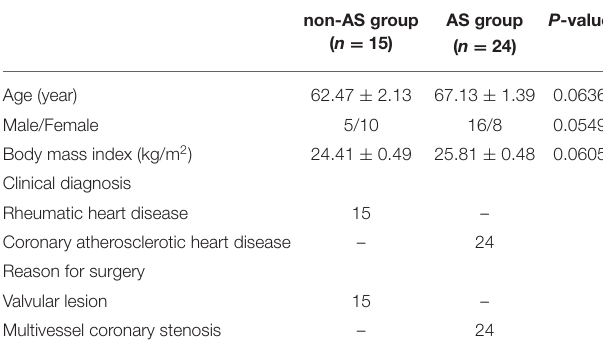
TABLE 1 | Characteristics of